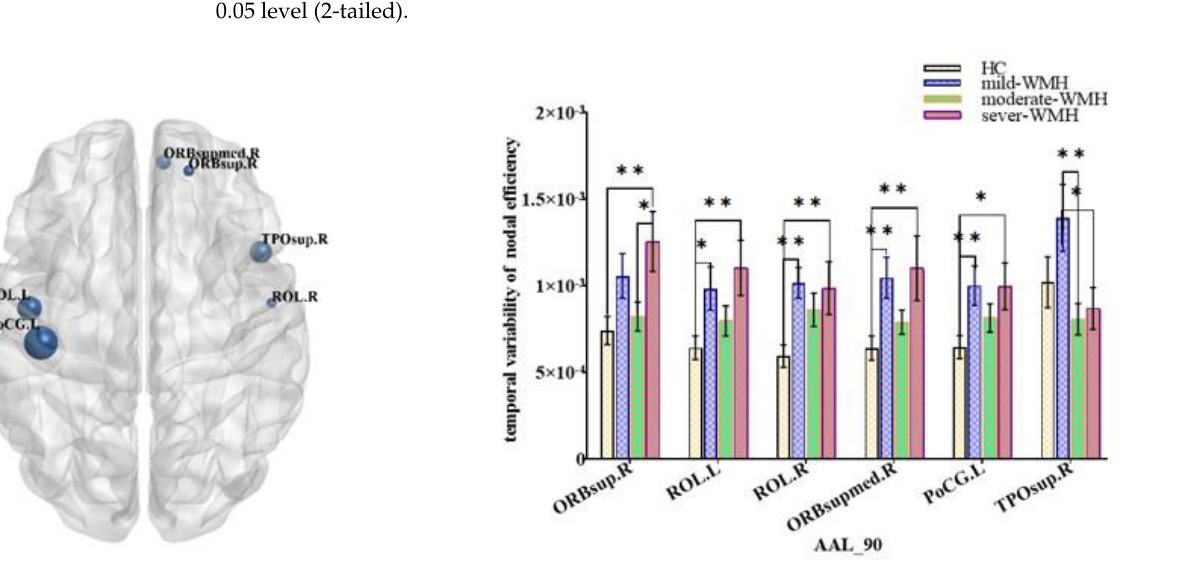
Figure 1. Group comparisons of the temporal variability of betweenness centrality. Right rectus gyrus (REC.R), right inferior occipital lobe (IOG.R), right paracentral lobule (PCL.R), right dorsolateral superior frontal gyrus (SFGdor.R), left rectus gyrus (REC.L), and left orbital part of the superior frontal gyrus (ORBsup.R). *** significant at 0.001 level, ** significant at 0.01 level, and * significant at 0.05 level (2-tailed).